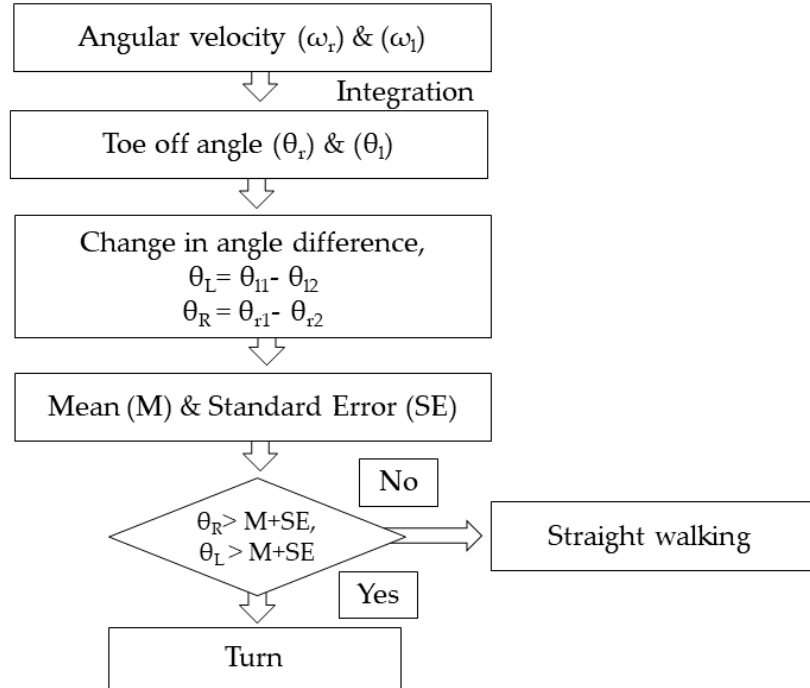
Figure 3. Flowchart to distinguish the turns from straight walking.